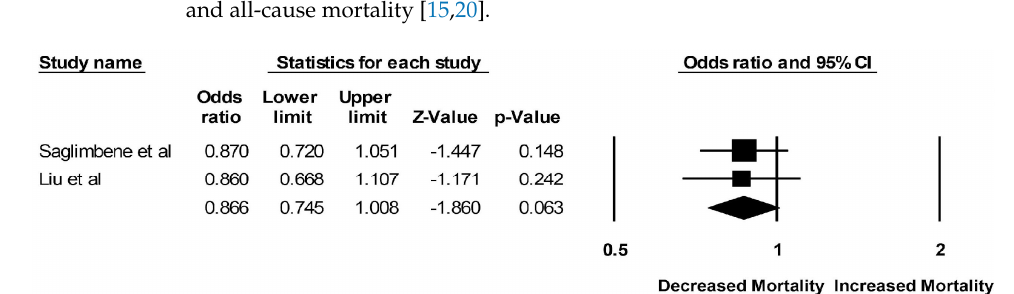
Figure 3. Forest plots of the included studies assessing outcomes defined as a plant-based diet and all-cause mortality [17,18].